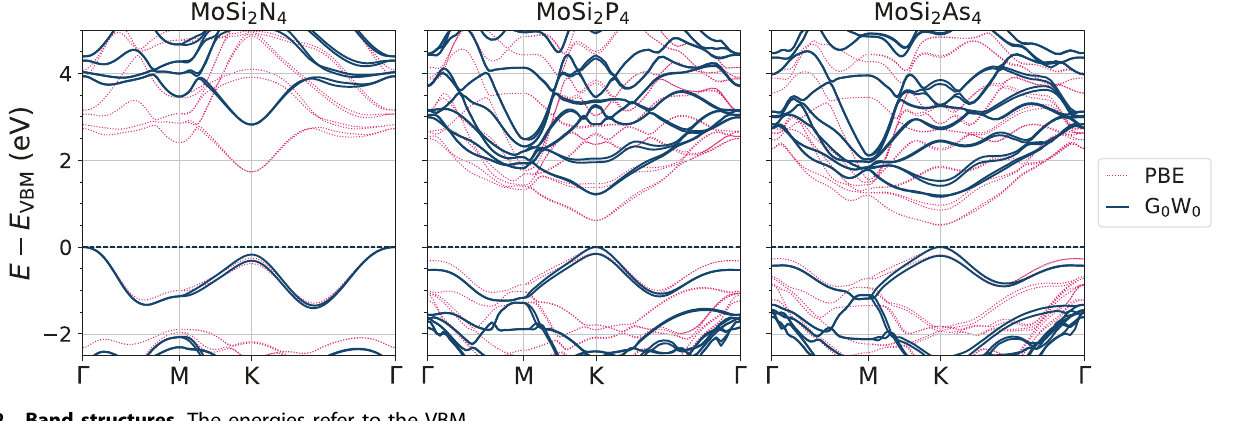
Fig. 2 Band structures. The energies refer to the